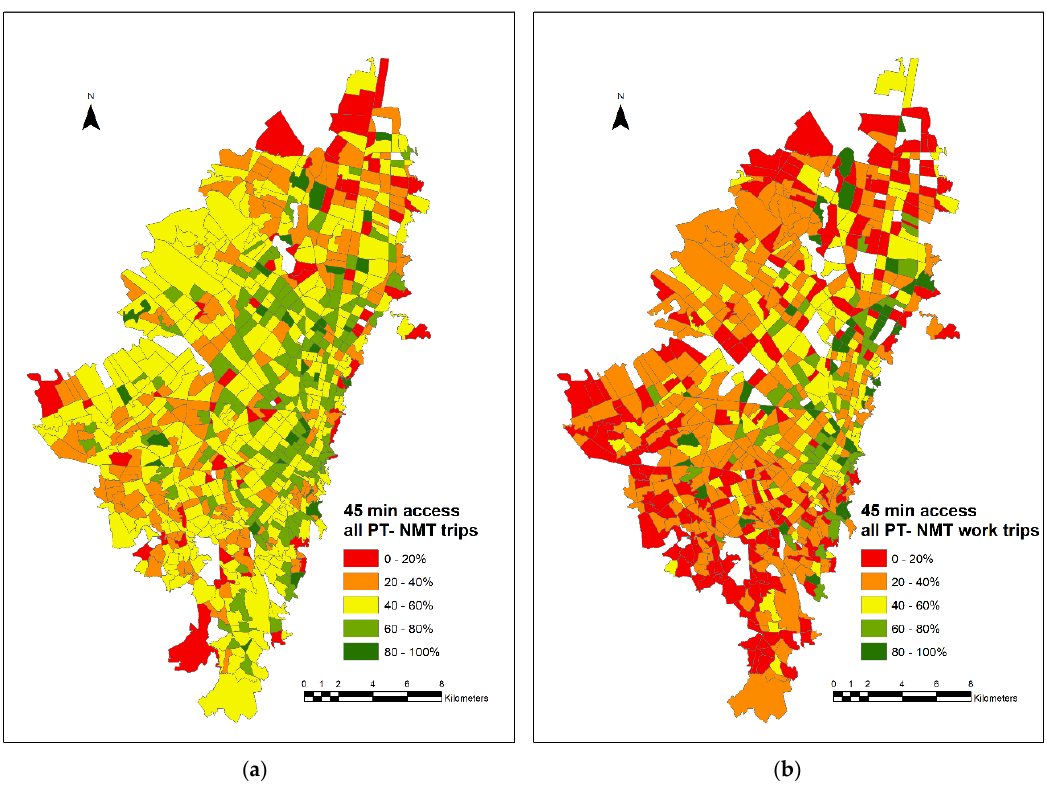
Figure 5. The proportion of people who reach their activity location within 45 minutes by public transport (PT), walking or cycling (NMT), for all trip purposes ( a ) and for work trips ( b ).